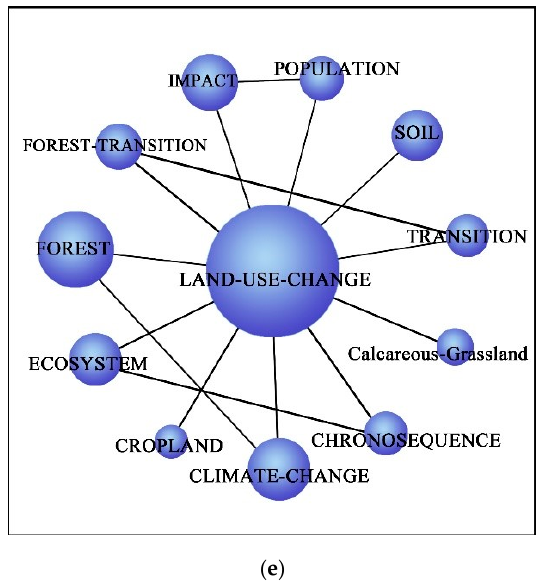
Figure 7. Farmland abandonment strategic diagram and-cluster network (2005–2011). ( a ) Strategic diagram for the 2005–2011 period; ( b ) pattern-cluster network map; ( c ) landscape-cluster network map; ( d ) disturbance-cluster network map; ( e ) land-use-change-cluster network map.